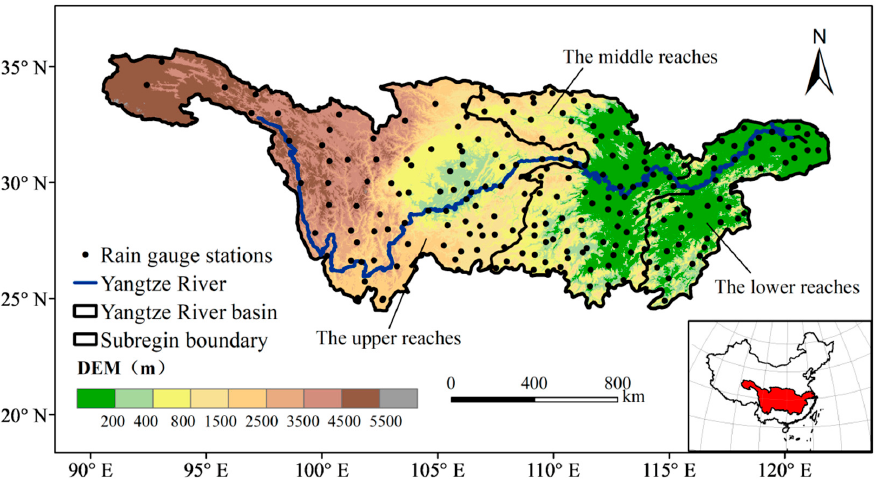
Figure 1. A map of the Yangtze River basin, including elevation, river, location of the meteorological stations, as well as the spatial distributions of three